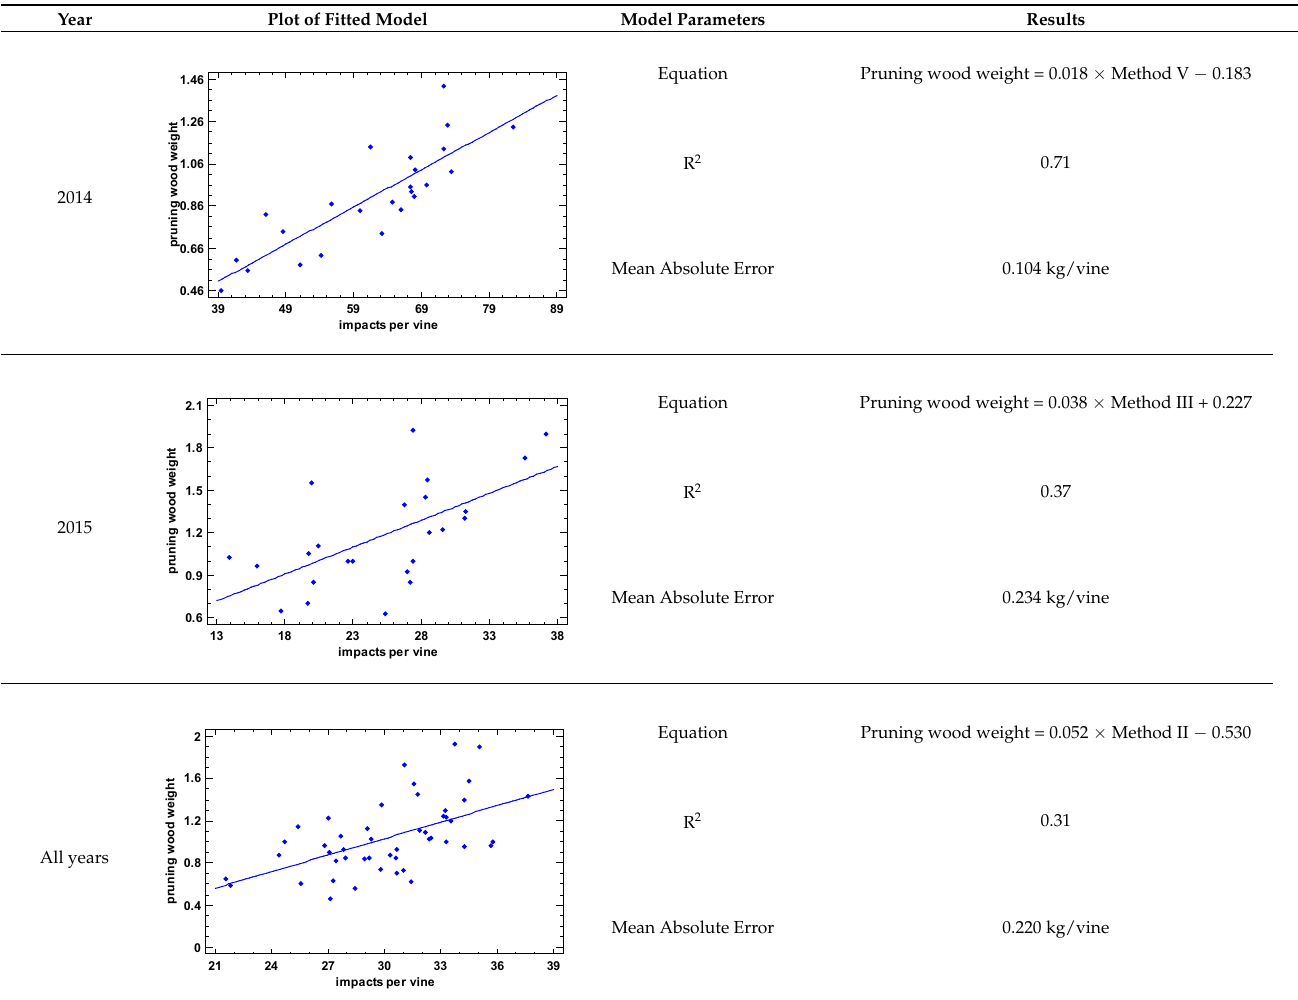
Table 5. Descriptive statistics of measurements for the Syrah cultivar.